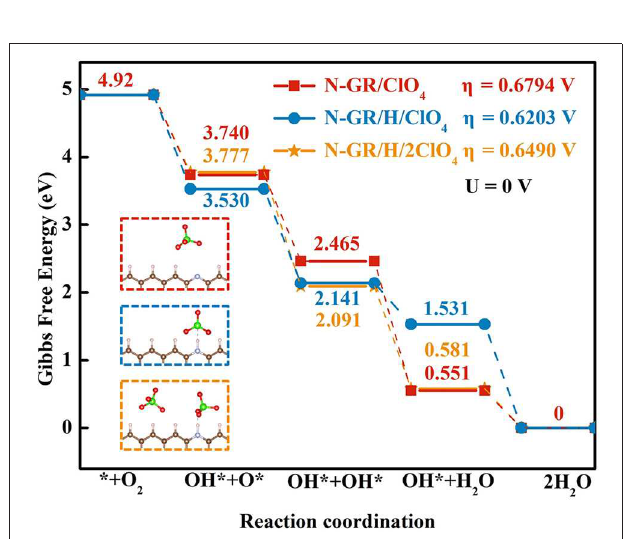
FIGURE 6 | The reaction Gibbs free energy of four elementary steps of ORR on N-GR/ClO − 4 , N-GR/H/ClO − 4 , and N-GR/H/2ClO − 4 . The corresponding structural models are in the dotted